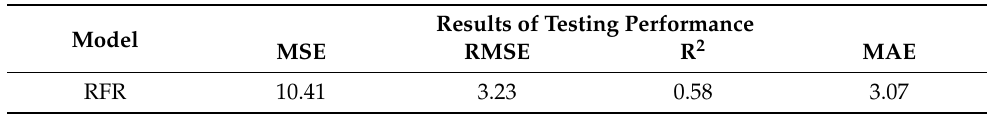
Table 7. The testing phase (compressive strength) with available RFR models’ yielded statistical data from the applied prediction